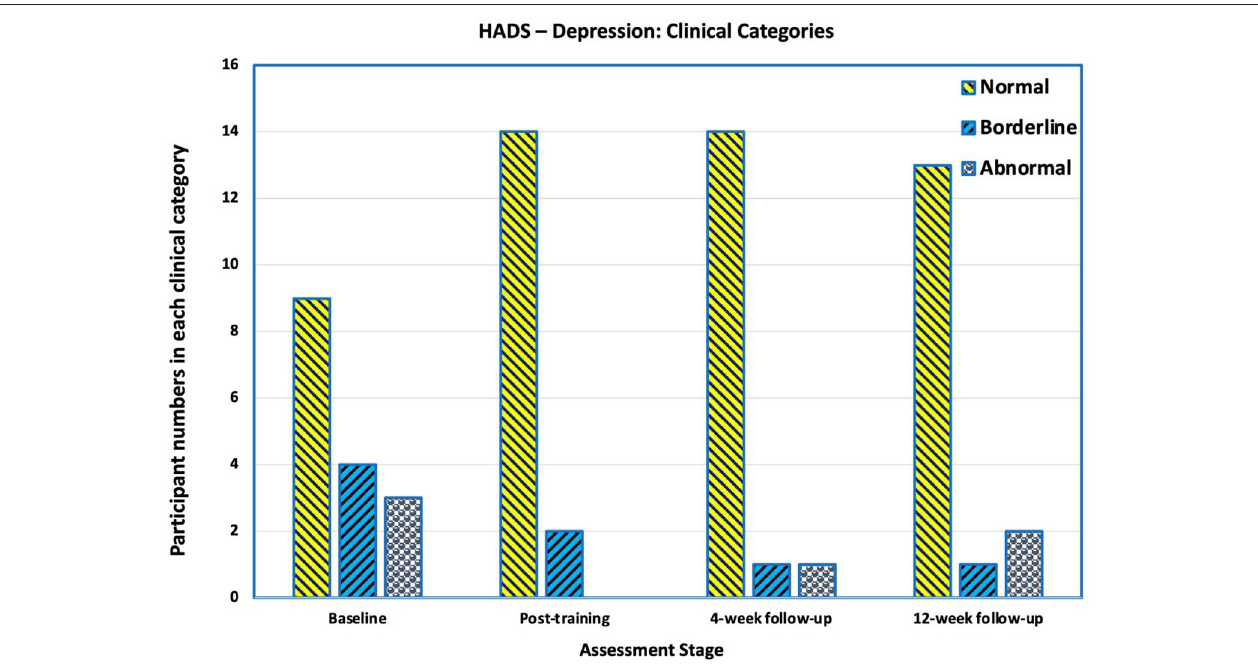
FIGURE 8 | Number of participants in each category in Hospital Anxiety and Depression Scale (HADS) for Depression. Scores of > 10 are “abnormal” and indicative of clinical depression, scores between 8 and 10 are categorised as borderline, and scores below 8 are categorised as normal. Before training, three participants had scores indicating clinical depression. After training, none had scores indicating clinical depression. There was a slight deterioration at 4- and 12-weeks’